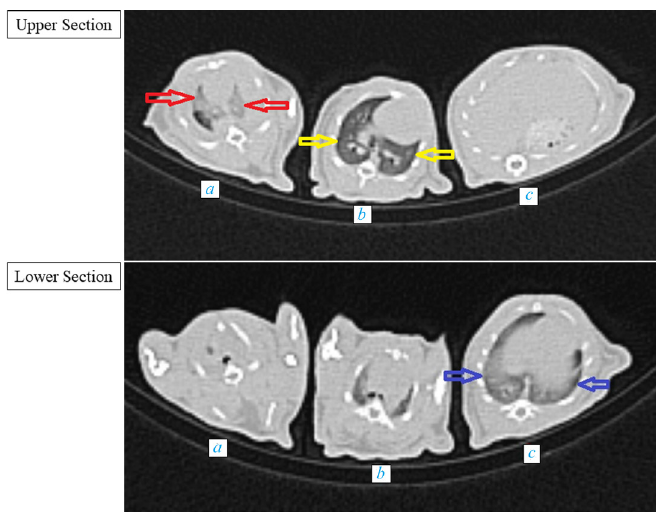
Figure 1. ( a ) Radiological examination with multidetector computed tomography (MDCT) revealed diffuse pulmonary oedema in the lungs of the rats in the cytarabine (CYT)group (upper section). ( b ) No oedema was seen in lungs of the rutin+cytarabine (R+CYT) group (upper section). ( c ) The lungs of the control (HG) animals had a normal appearance (lower